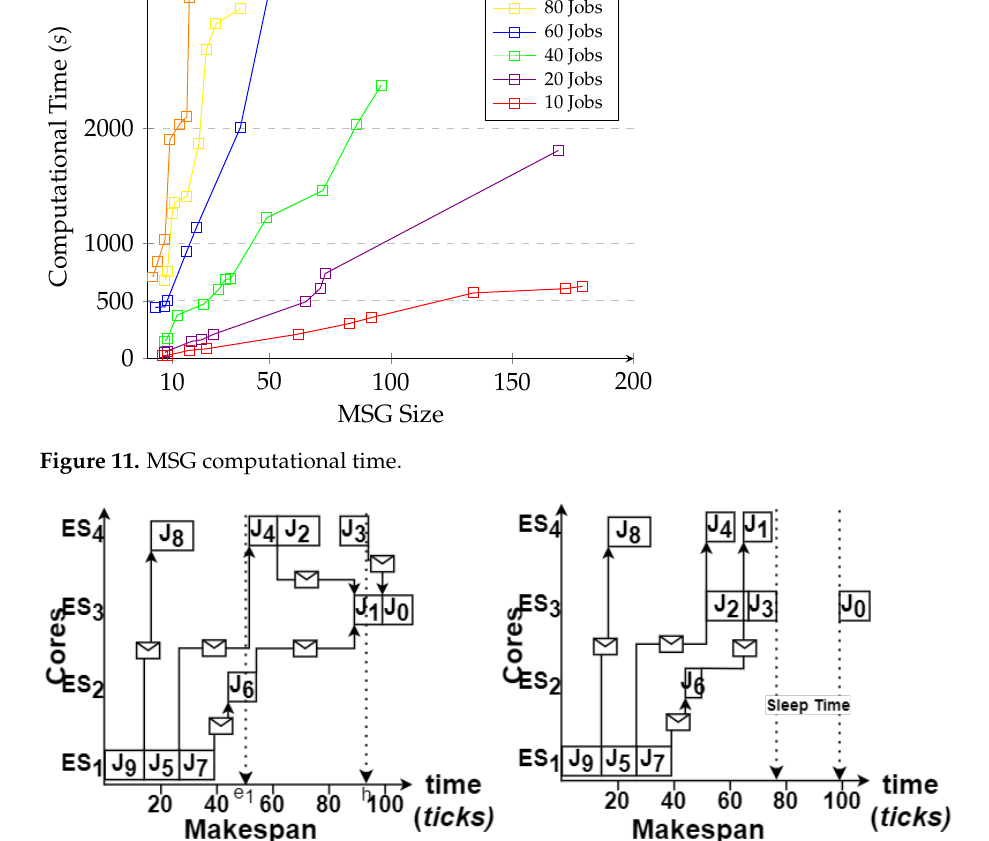
Figure 12. Algorithm 2 generation of sleep